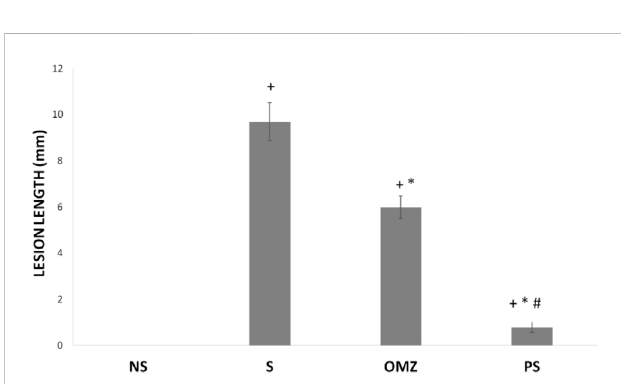
FIGURE 2 Effects of P. sarmentosum (500 mg/kg; PS) and omeprazole (20 mg/kg; OMZ) on gastric lesion length (in mm) in rats exposed to WIRS.Barsrepresentmean±SEM( n =7).Key:+, p < .05comparedtothe non-stress (NS) control group; *, p < .05 compared to the stress (S) control group; #, p < .05 compared to the OMZ-treated